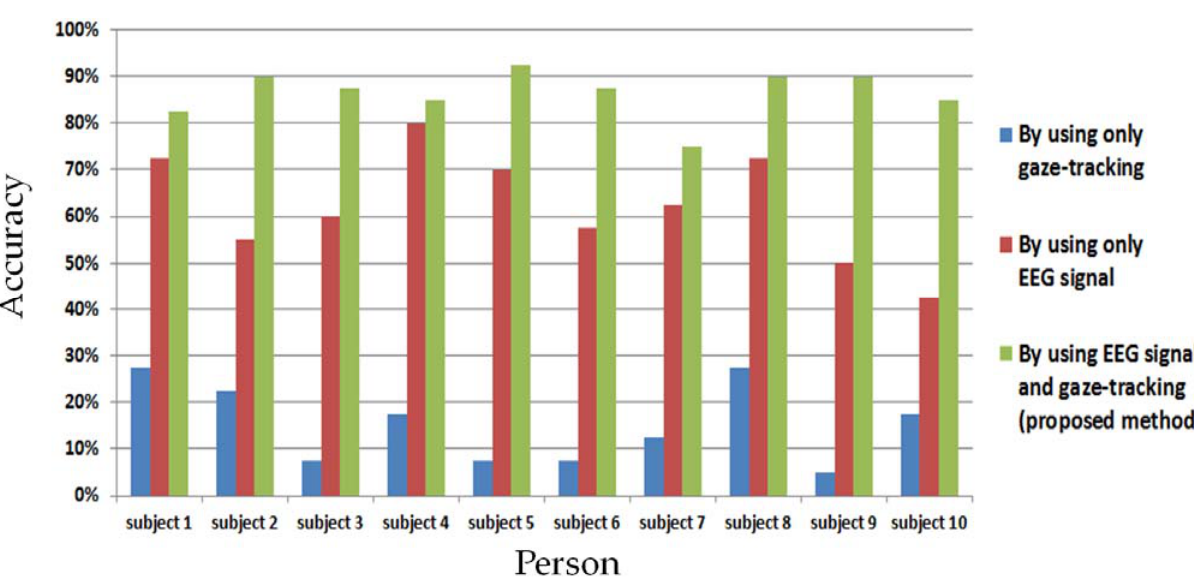
Figure 5. Comparisons of accuracies of three methods: checking EEG signals in the 12 × 12 matrix area without gaze position (by using only EEG signals), checking EEG signals in the 3 × 3 matrix area defined by gaze position (proposed method), and checking in the entire 12 × 12 matrix area with the gaze position (by using only gaze-tracking).